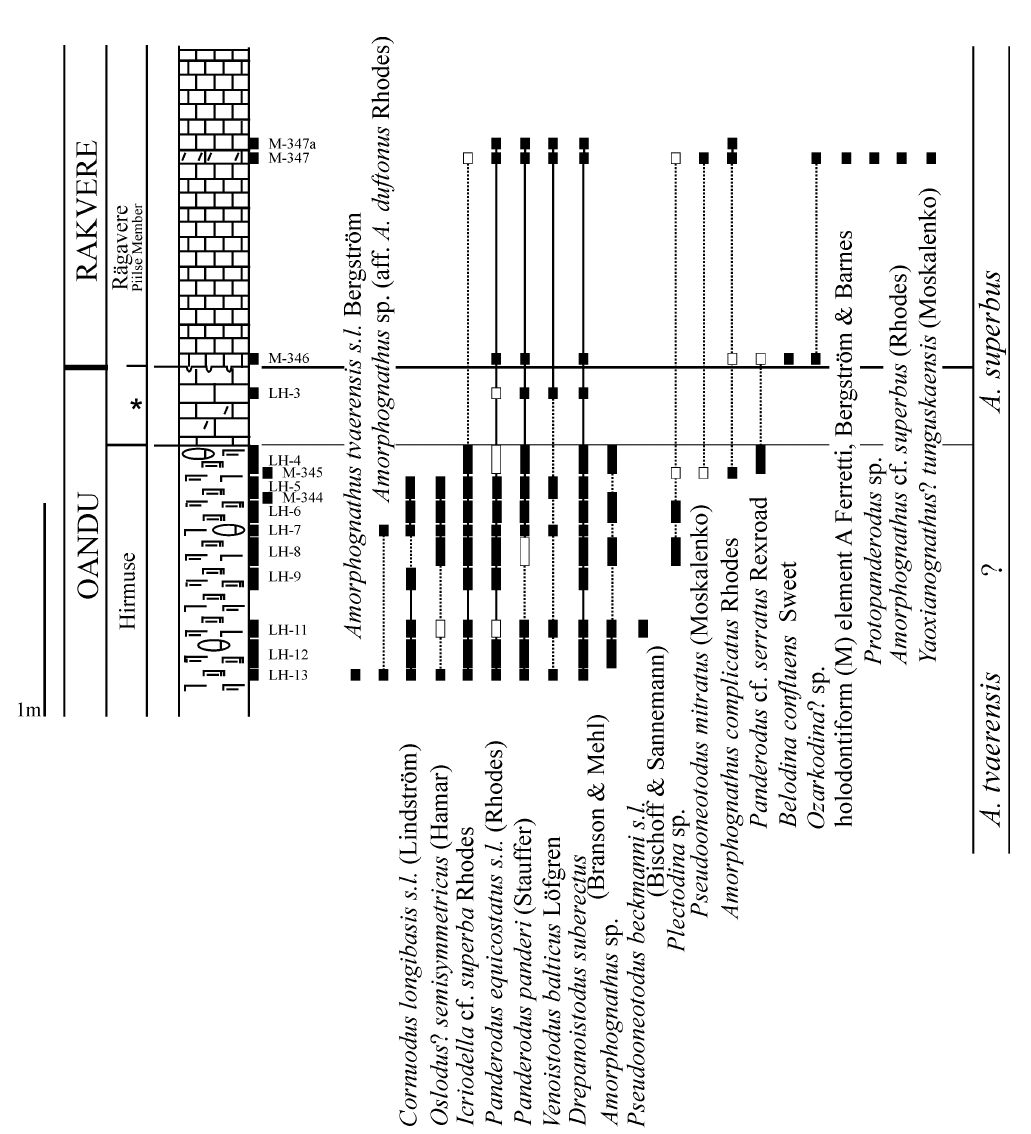
Fig. 6. Distribution of conodonts in the Ussimägi section. For the explanation and legend refer to Fig. 3. Just to the right of the log sample numbers are indicated instead of